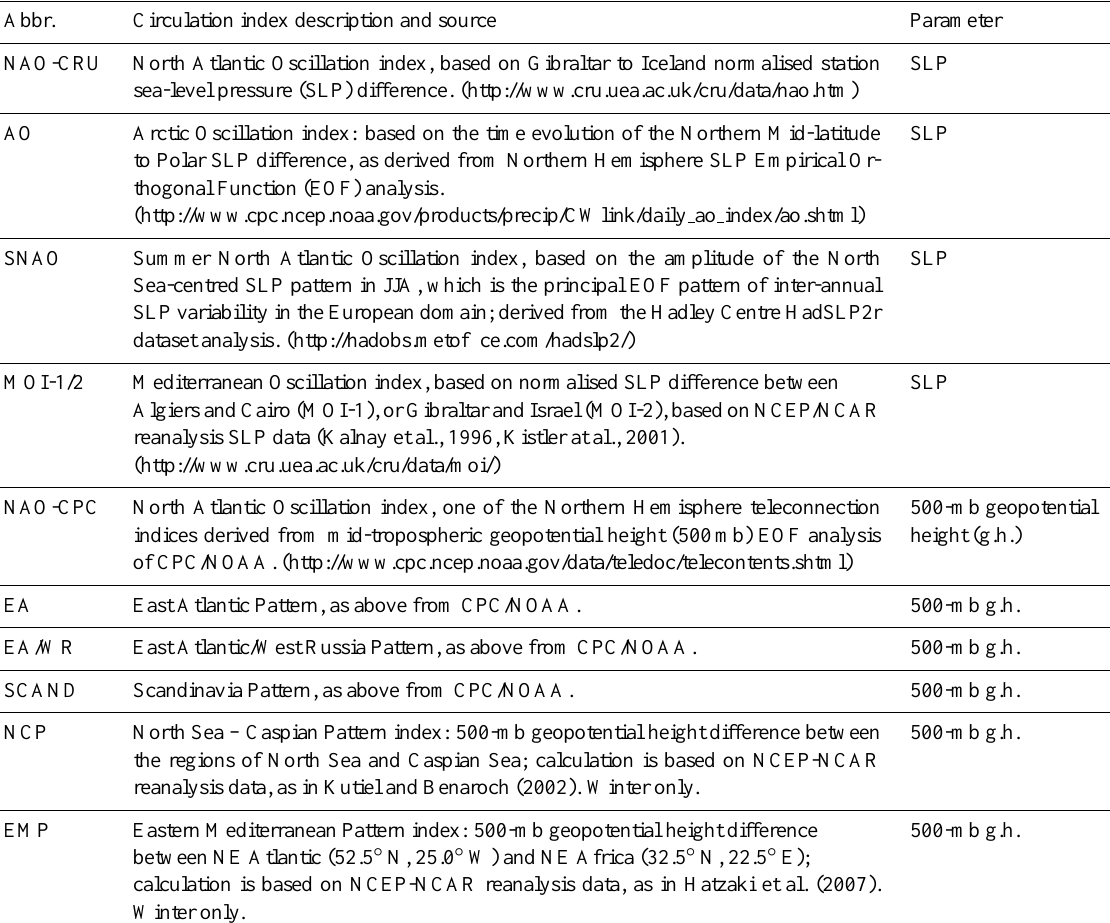
Table 3. Atmospheric circulation indices.